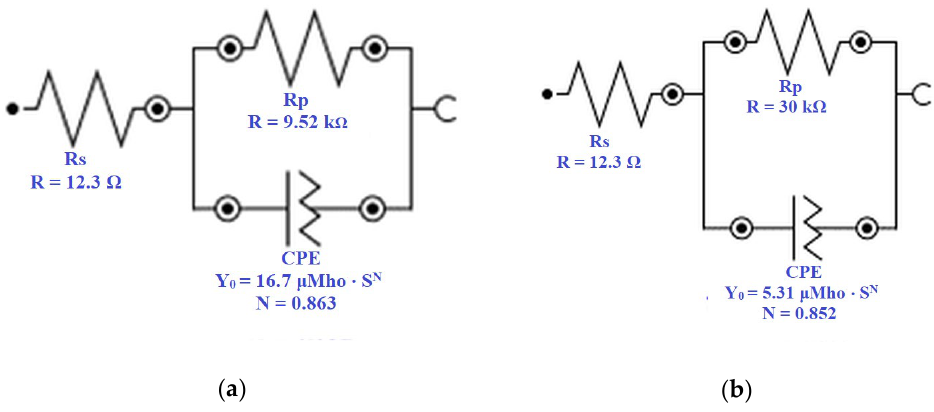
Figure 7. Electrical equivalent circuits for the (a) Ti-TiO 2 -1h and (b) Ti-TiO 2 -rGO-1h structures.